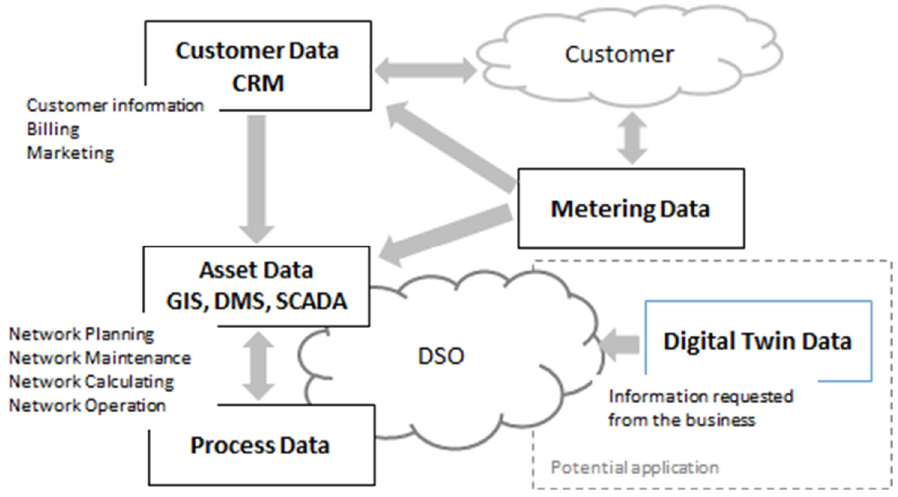
Figure 1. Example of a data-management flow for a distribution operator’s IT infrastructure.